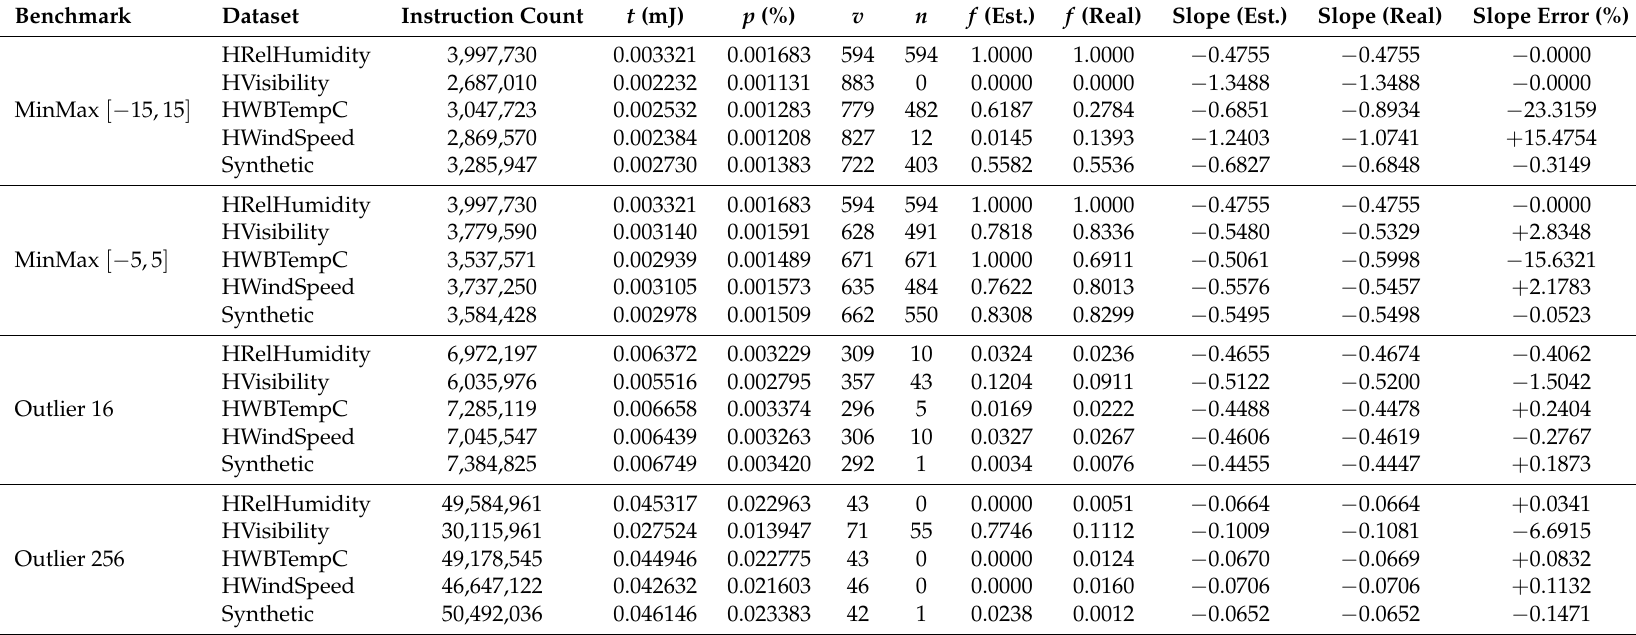
Table A7. Raspberry Pi 3 energy consumption results in cloud-prone